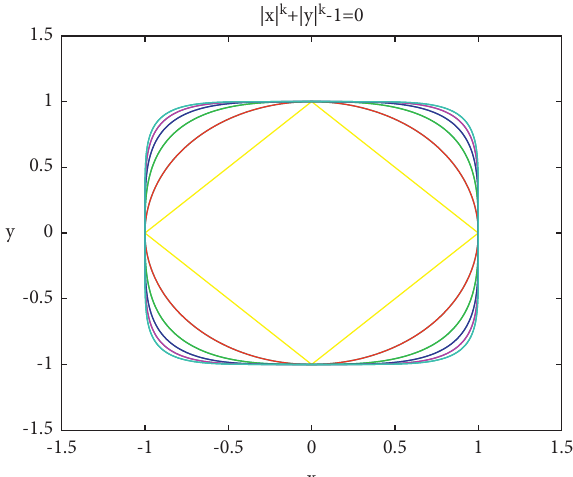
Figure 2: Set of equilibrium points of different shapes of the system when k � 1 , 2 , 3 , 4 , 5 ,